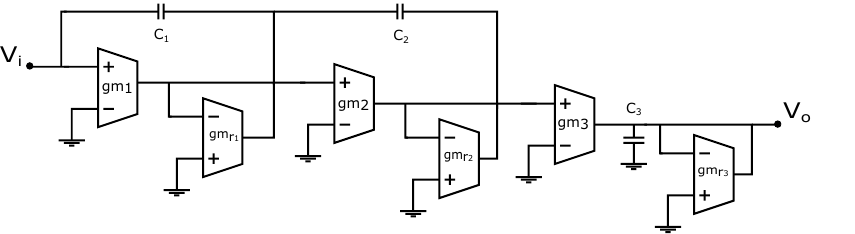
1 that is approximated by (7), and designed by cascading s 0.9